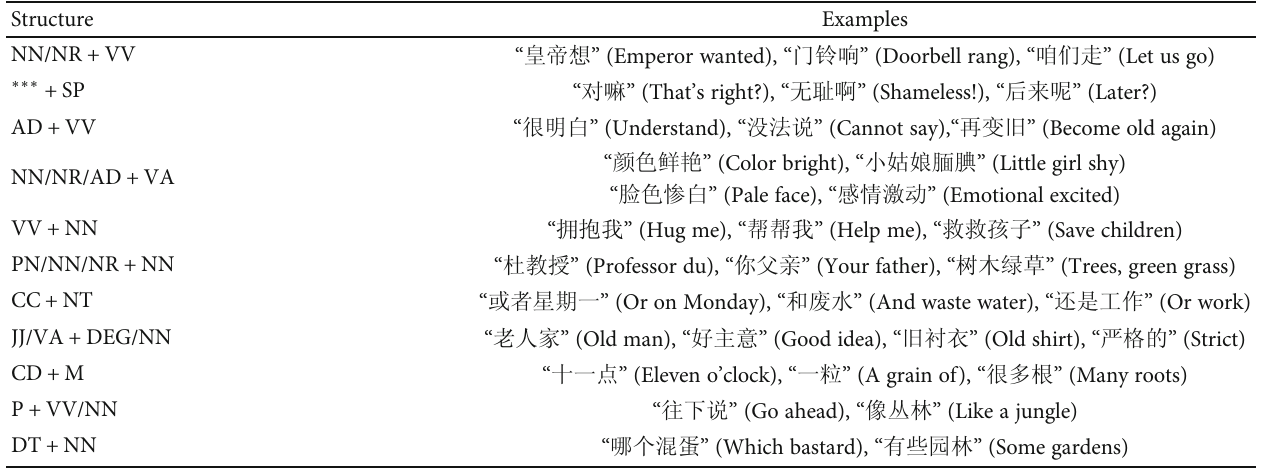
Table 11: Text book 2-gram list